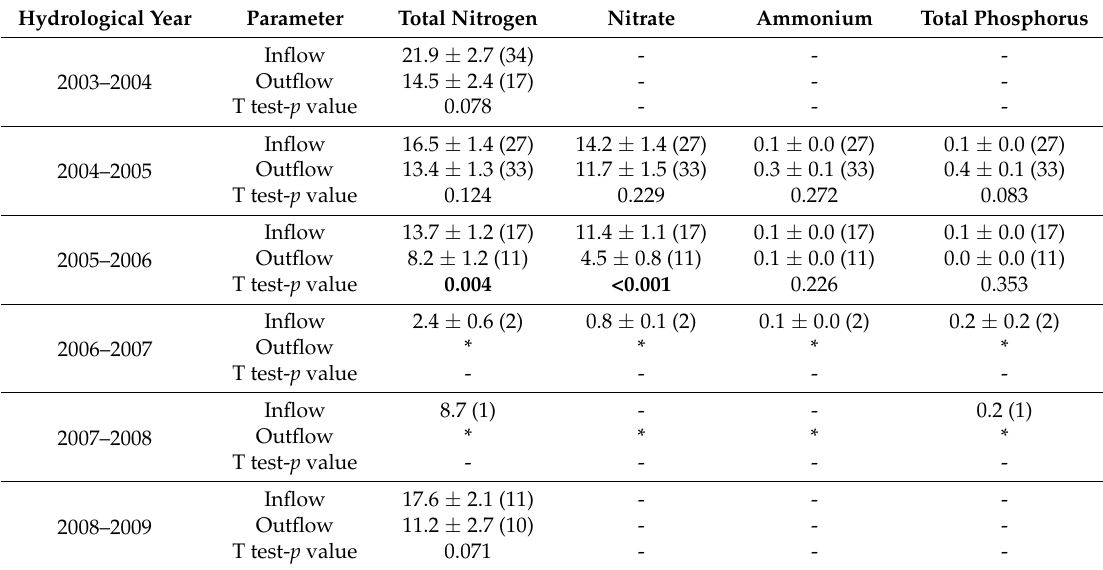
Table 1. Average concentrations of different parameters (mg · L − 1 ) at the inlet and outlet of the monitored system (values are displayed as: mean ± st. error and number of samples in